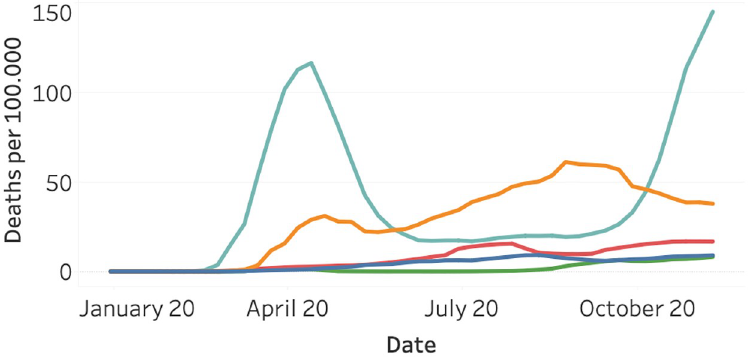
Fig 8. Covid-19 deaths per 100,000 inhabitants as of January 2020, split per continent. North America (orange), South America (yellow), Asia (red), Europe (light blue), and Oceania (Green).